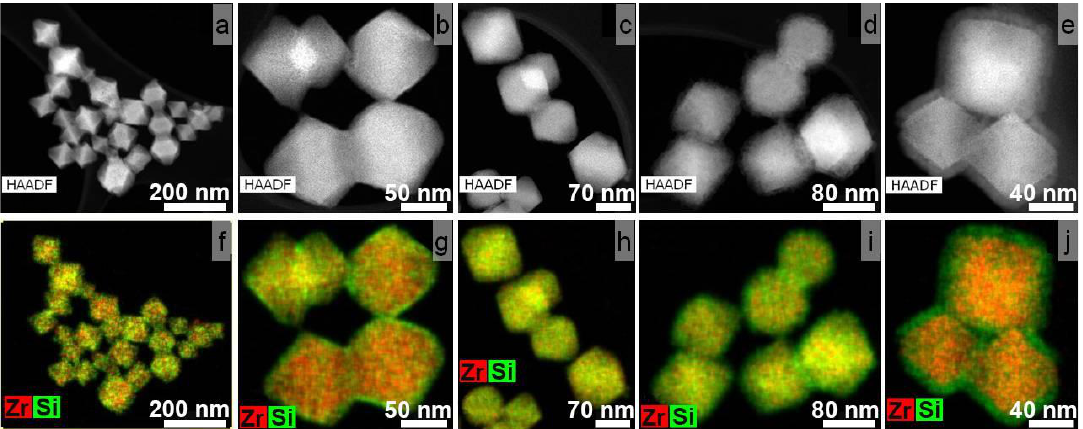
Figure 2. HAADF-STEM images and corresponding Zr-Si elemental maps for UiO-66@SiO 2 samples obtained by incubation of PVP-grafted UiO-66 MOFs in TEOS for 0.5 ( a , f ); 1 ( b , g ); 2 ( c , h ); 4 ( d , i ); 24 h ( e , j